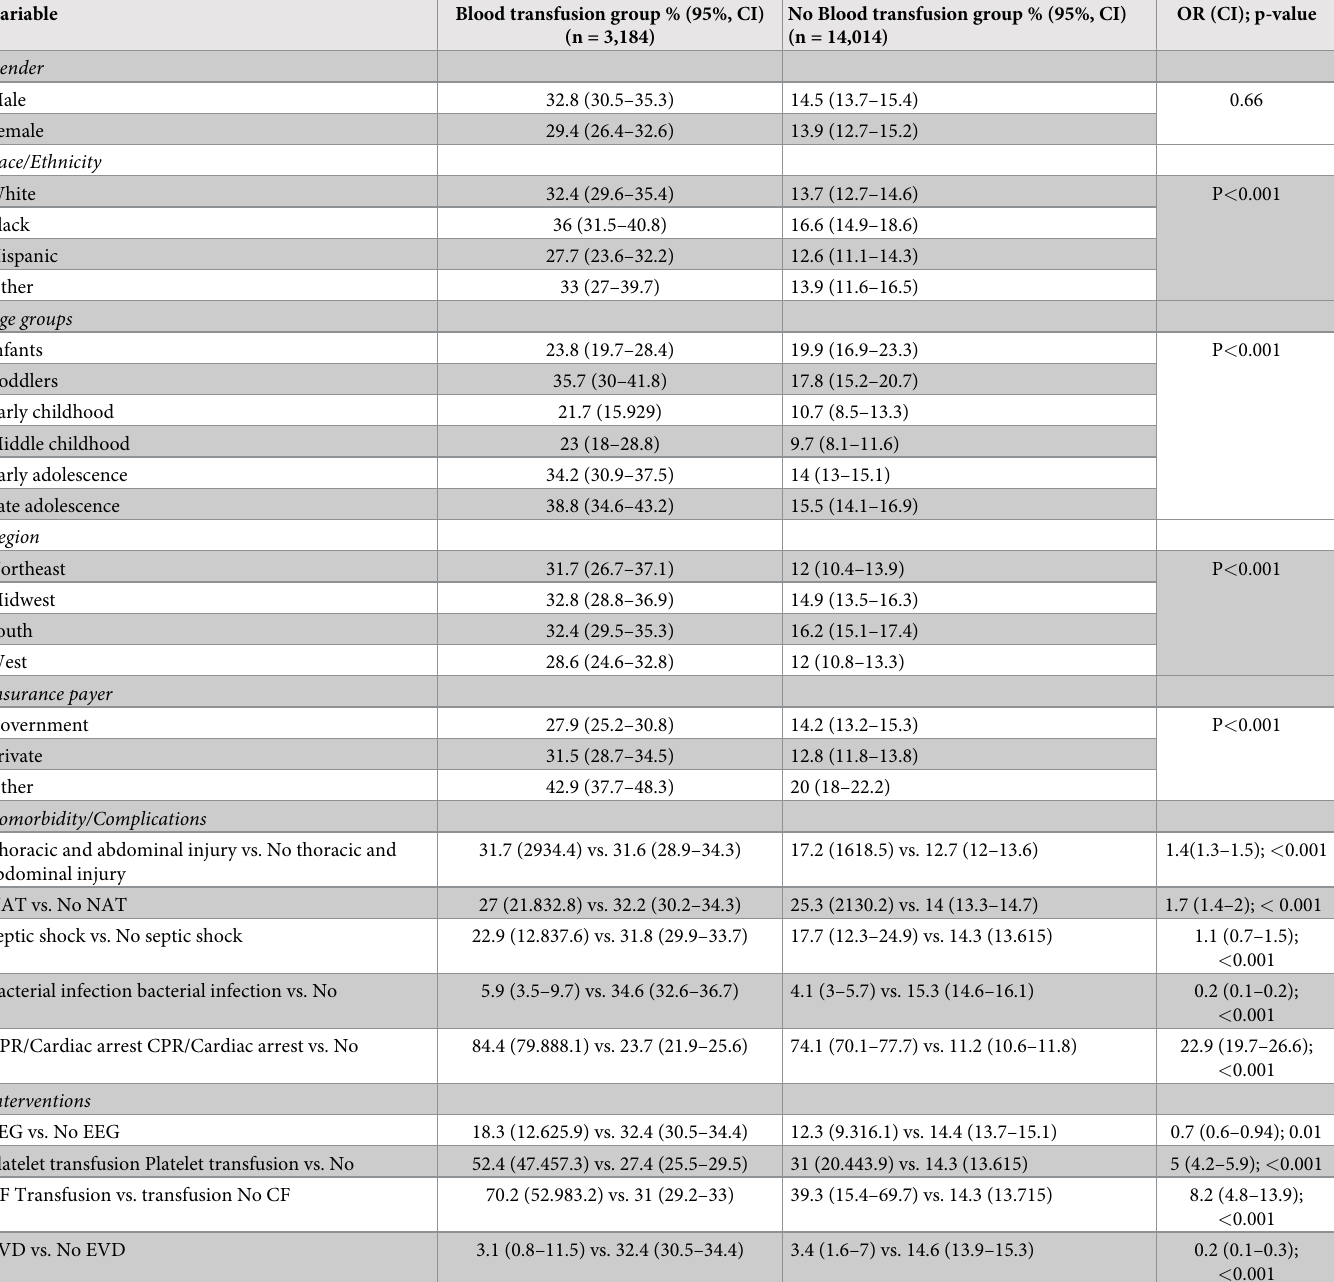
Table 3. Univariate analysis of mortality among children with traumatic brain injury and mechanical ventilation with and without blood transfusion therapy. The values are presented as percentages (95% Confidence intervals).